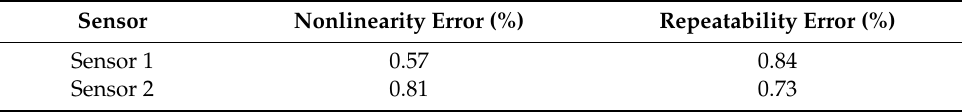
Figure 6. The results obtained using the bladder test, validation of PicoPress ® sensors readings against the VLCM reading. The error bars represent the 95% confidence interval ( a ), ( b ) represents the two PicoPress ® sensors. Table 4. Repeatability and non-linearity error (%) for PicoPress ® sensors. Table 4. Repeatability and non-linearity error (%) for PicoPress ®